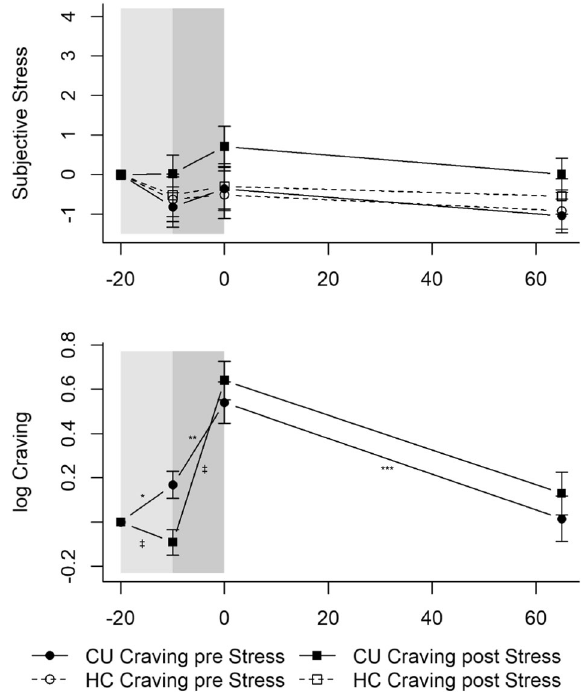
Fig. 4 Mean levels and standard errors of the mean for subjective stress and craving during the Cocaine-Cue-Video. Gray shaded areas indicate the Cocaine-Cue-Video. Values were normalized by subtracting the levels measured at T 1 ( − 20 min) from all other values to facilitate interpretation of the stress and craving reaction independently of effects of the circadian rhythm or baseline differences ( T 0 ). The Cocaine-Cue-Video did not induce a subjective stress response but elicited craving with cocaine users that underwent the Cocaine-Cue-Video after the TSST showing an enhanced craving response. CU Cocaine users, HC Healthy controls. CU Craving pre Stress: * p < 0.05; ** p < 0.01; *** p < 0.001; CU Craving pre Stress vs. CU Craving post Stress: ‡ p < 0.05. CU Craving pre Stress: n = 22; CU Craving post Stress: n = 25; HC Craving pre Stress: n = 18; HC Craving post Stress: n = 20.